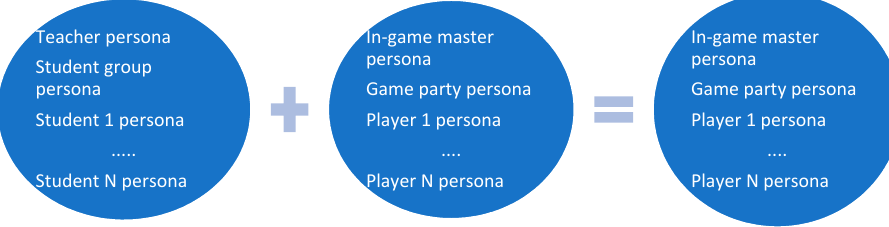
Figure 5. Game personas construction by integrating the educational with the gaming description.